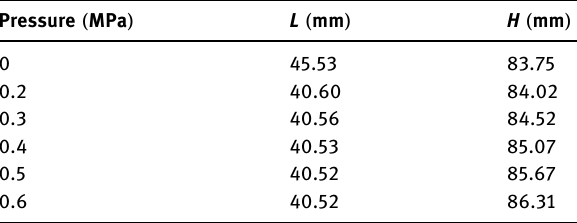
Table 2: Coordinates of maximum deformation height points of bump under di ff erent pressures